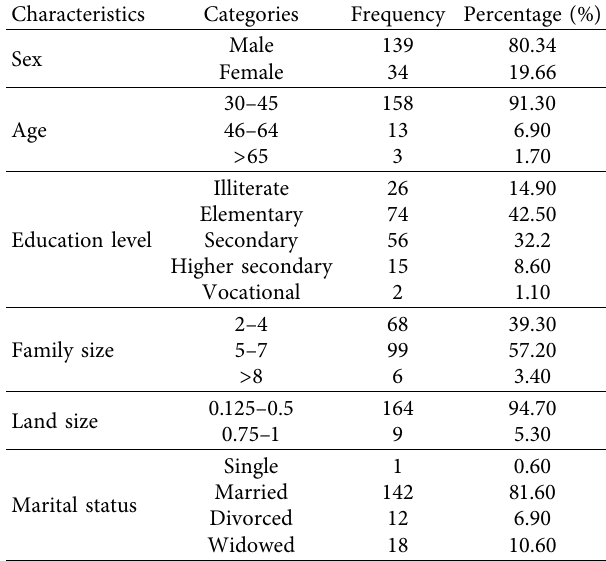
Table 3: Socioeconomic characteristics of respondents in the